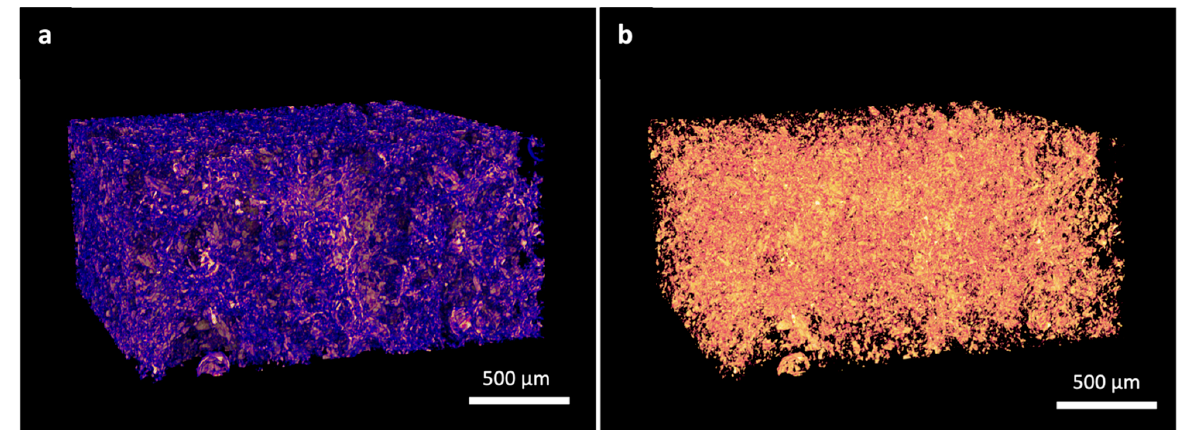
Figure 4. MicroCT reconstruction of representative sample: ( a ) mineral (yellow) and polymeric (blue) components separated by attenuation and overlaid; ( b ) mineral phase shown separately, average mineral content 8.49% (SD 3.65, n = 3).